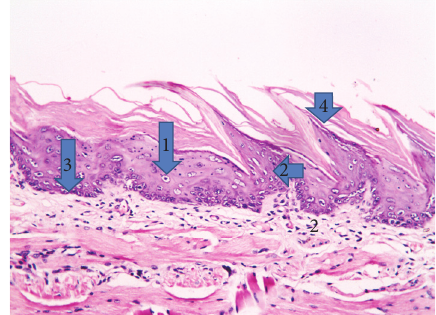
Figure 2: Photomicrograph of the dorsal surface of the tongue of the irradiated only group at 3 days following radiation showing (1) cytoplasmic perinuclear vacuolization, (2) apoptotic cells, (3) disturbed architecture of basal cells, and (4) keratin tips that were lost over some papillae (H&E, × 200).